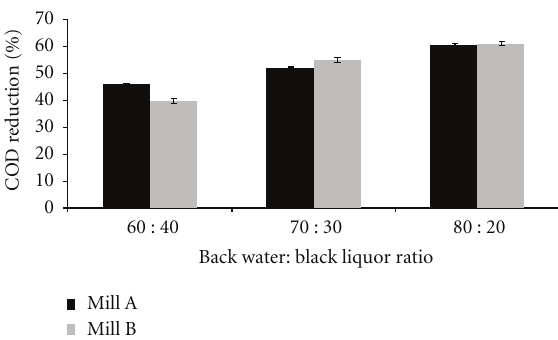
Figure 3: COD reduction of sample back water :black liquor (60:40, 70 :30, and 80:20) using C6 consortia after 20hrs of incu-